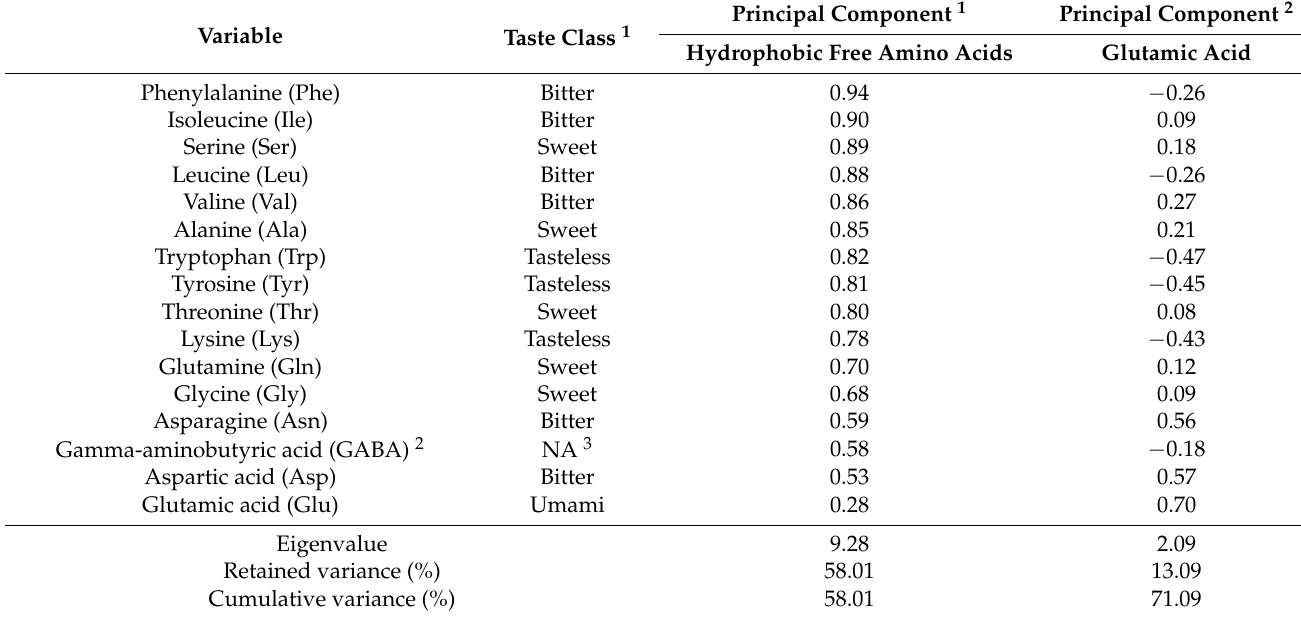
Figure 3) of the cumulative variance and were: hydrophobic free amino acids (PC1) and glutamic acid (PC2). The hydrophobic free amino acids in dry cacao beans were strongly correlated with PC1 (Table 7). On the other hand, the most correlated free amino acid with PC2 was glutamic acid (Table 7), which is the third most abundant amino acid in samples of PH-16 dry cacao beans (Table 3). Table 7. Summary of principal component analysis applied to the free amino acids of PH-16 dry cacao beans correlated with samples represented by Scott–Knott average groups for the Soil Quality